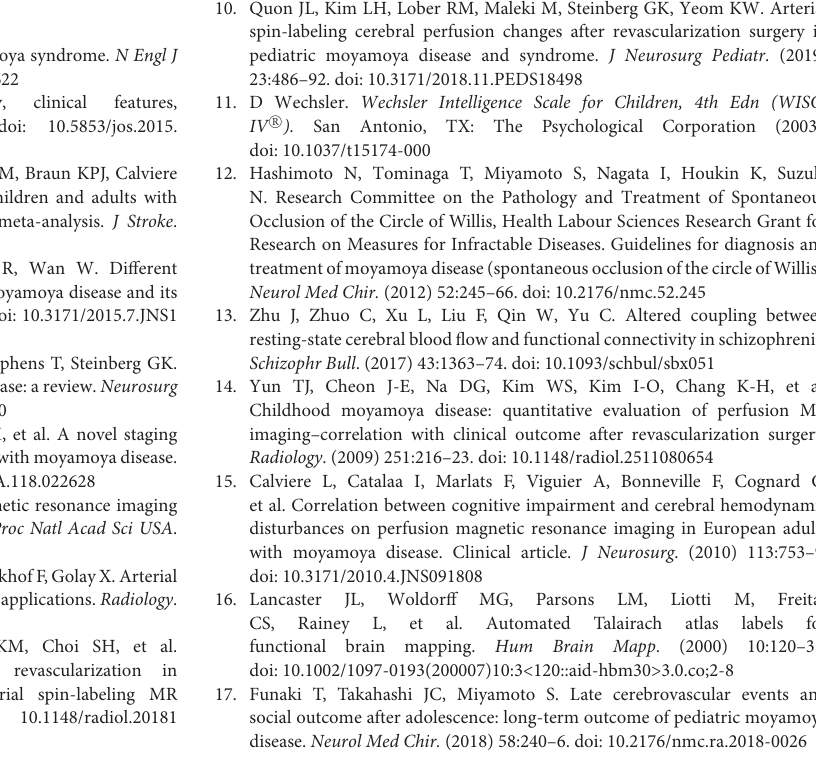
Supplementary Figure 1 | Illustration of lobular ROIs used for regional cerebral blood flow extraction. ROIs of the two hemispheres were symmetrical. Only the ROIs of the left hemisphere were presented. (A) Frontal lobe; (B) parietal lobe; (C) occipital lobe; and (D) temporal